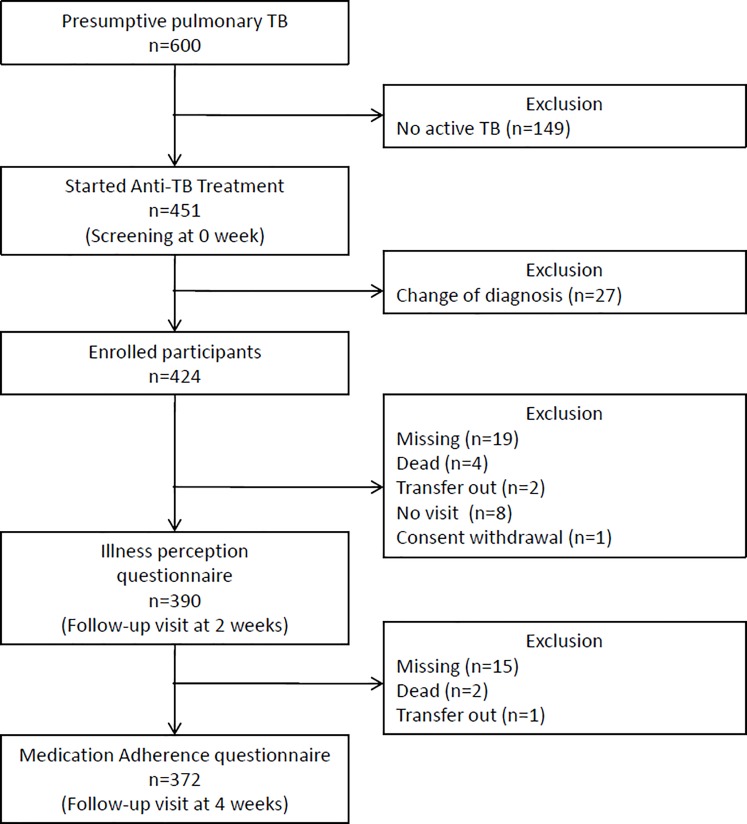
Enrollment flow-chart.